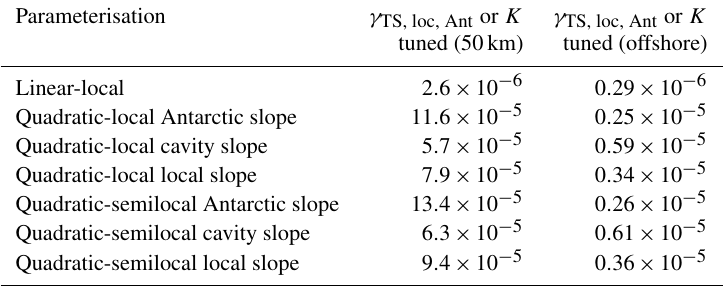
Table 4. Summary of the best-estimate parameters ( γ TS, loc, Ant and K ; see Eqs. 9 and 16) tuned over the full 35 ice shelves and 127 years for the simple parameterisations. For the Antarctic slope parameterisations, K is inferred by assuming that sin θ Ant = 2 . 9 × 10 − 3 , which is the average over all local slopes in our virtual